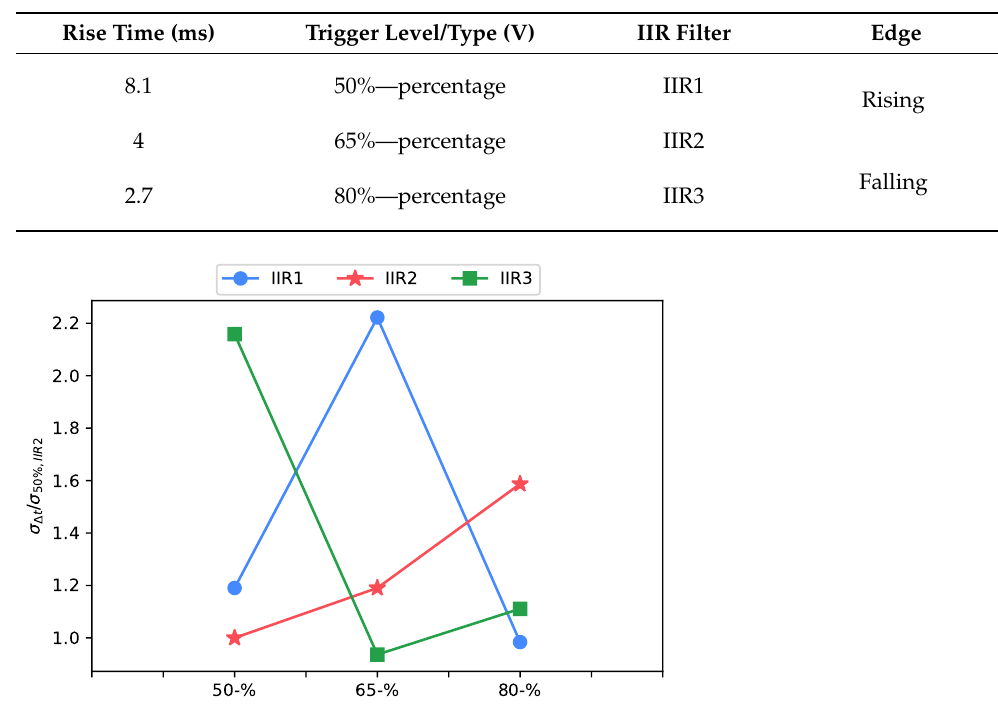
Table 3. Parameters used during the experimental tests with percentage trigger, adjacent interpolation and 1.5 V as full scale level.